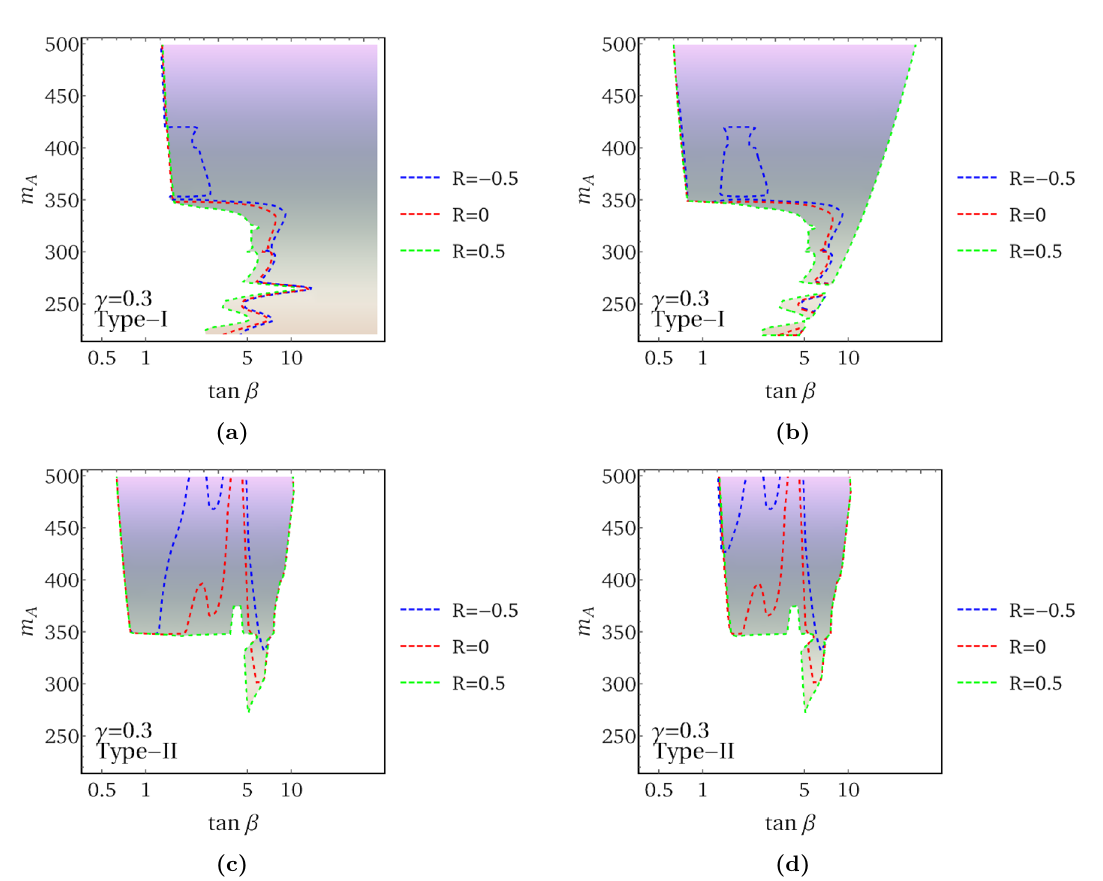
Figure 5. Experimental and tuning bounds for different R values. The allowed shaded regions inside and/or above each respective contour satisfy all experimental bounds in addition to exhibiting a tuning of at most 5% in ∆ m 2 (left) and m 2 (right). Panels (a) and (b) show the results for Type-I 12 Yukawa couplings, and panels (c) and (d) show the results for Type-II Yukawa couplings. All panels employ the γ = 0 . 3